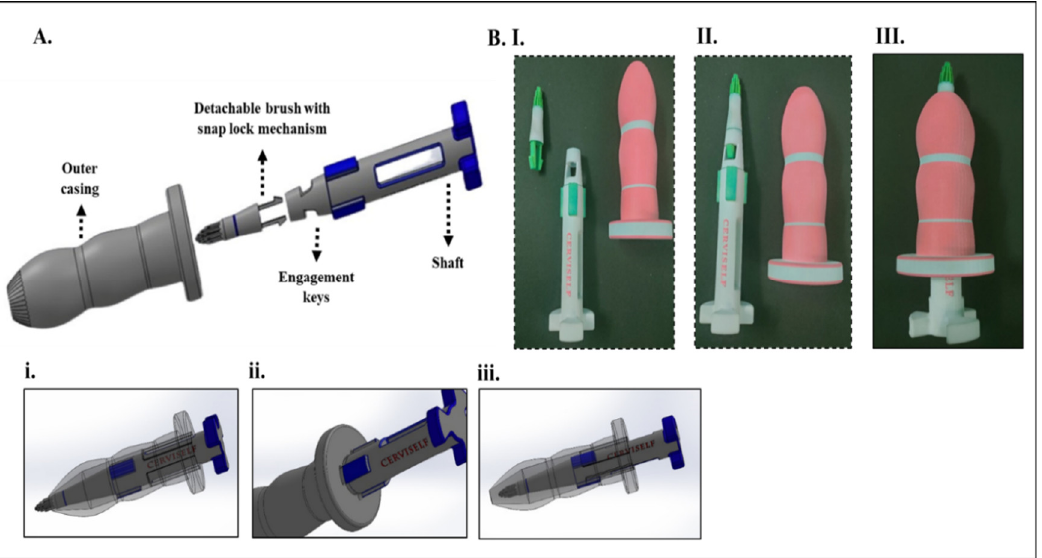
Figure 6. CerviSelf design 2. ( A ) CAD model showing different components. Figures showing ( i ) locking and insertion, ( ii ) alignment of keys, and ( iii ) withdrawal of brush. ( B ) 3D printed prototype of the design showing ( I ) individual components, ( II ) alignment of head(with bristles) and handle, and ( III ) fully fixed design ready for insertion.